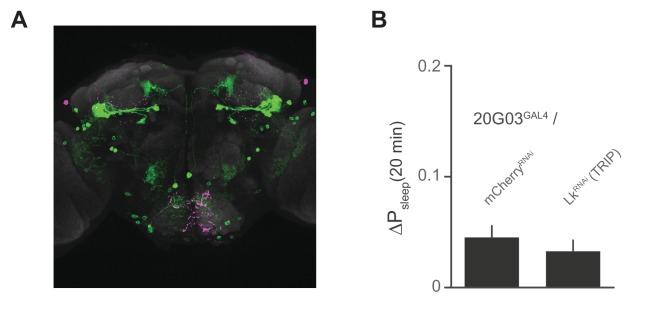
Lk immunostaining and knockdown in 20G03 neurons.(A) Confocal reconstruction of 20G03GAL4>mCD8::GFP. GFP-expressing neurons (green) with immunostaining for anti-Lk (magenta) and neuropil marker nc82 (gray), shows no co-localization of Lk in 20G03GAL4-labeled neurons. (B) RNAi of Lk in 20G03GAL4 neurons does not affect postprandial sleep (60 flies per genotype; n = 1118 meals, 20G03GAL4 / mCherryRNA; 1249, 20G03GAL4 / LkRNAi [TRIP]).